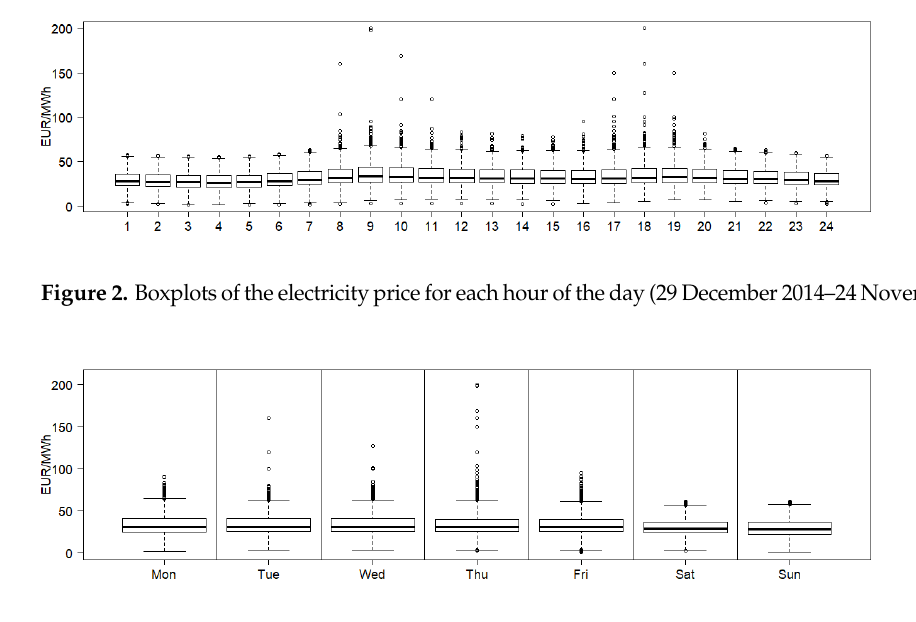
Figure 3. Boxplots of the electricity price for each day of the week (29 December 2014–24 November 2019).